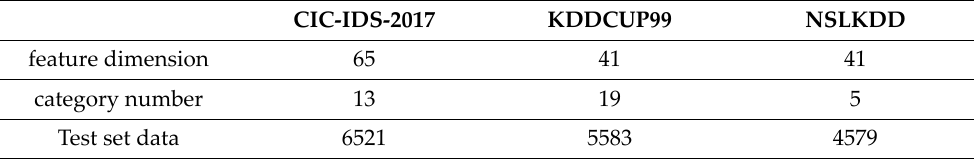
Table 3. Sample information after experimental dataset